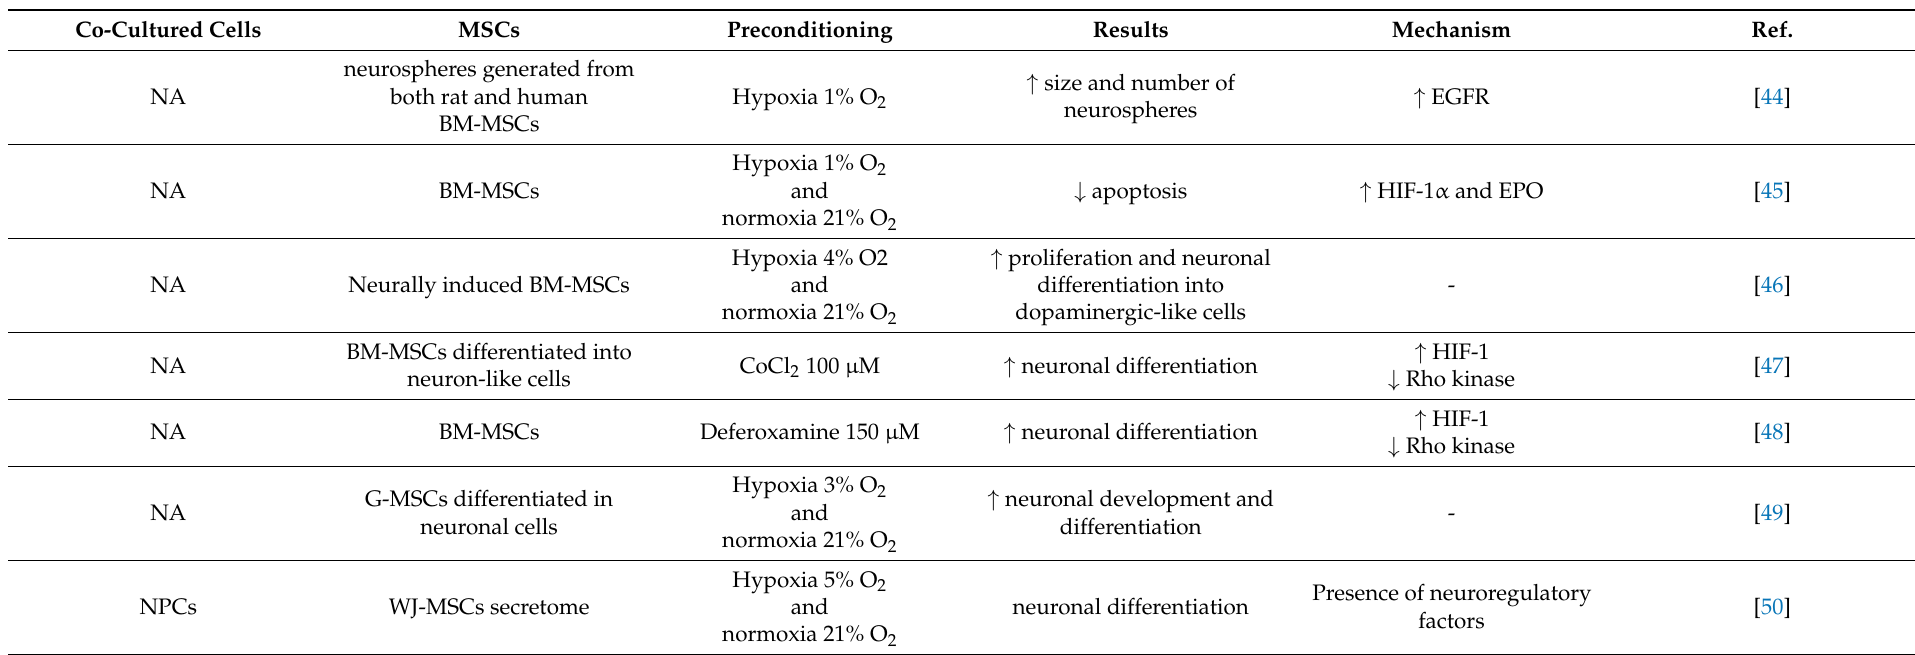
Table 1. Summary of in vitro studies that reported the effects of hypoxic preconditioning on neurodifferentiation and